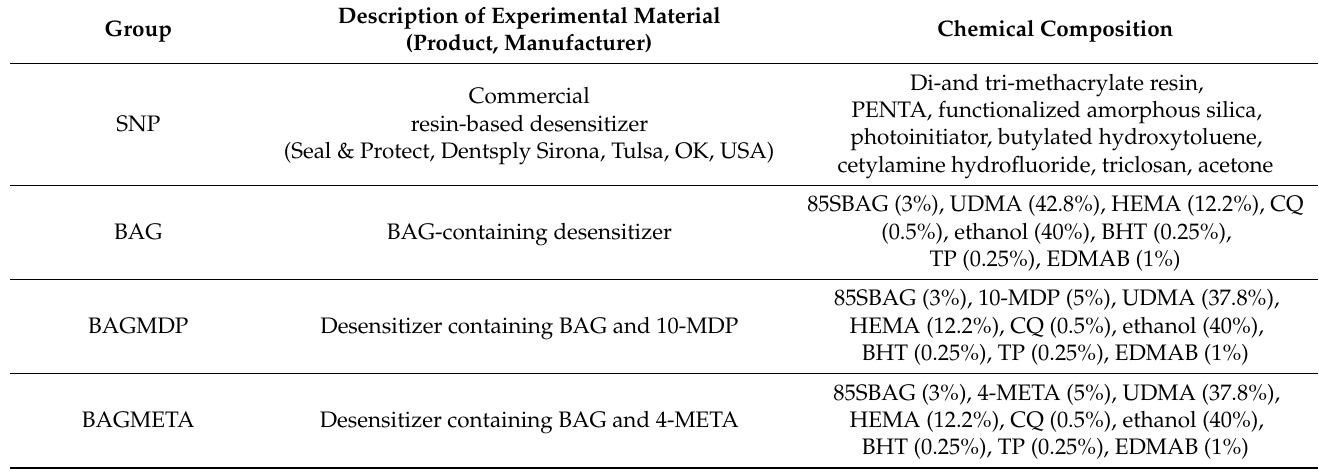
Table 1. Experimental groups and descriptions of the materials used in this